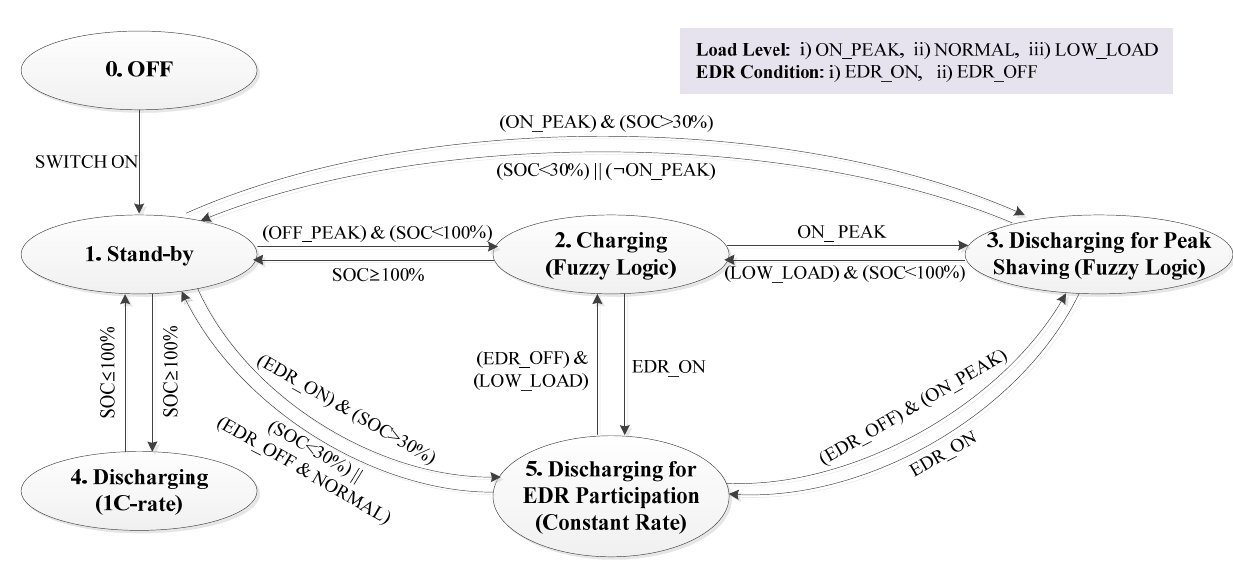
Figure 9. State transition diagram of battery